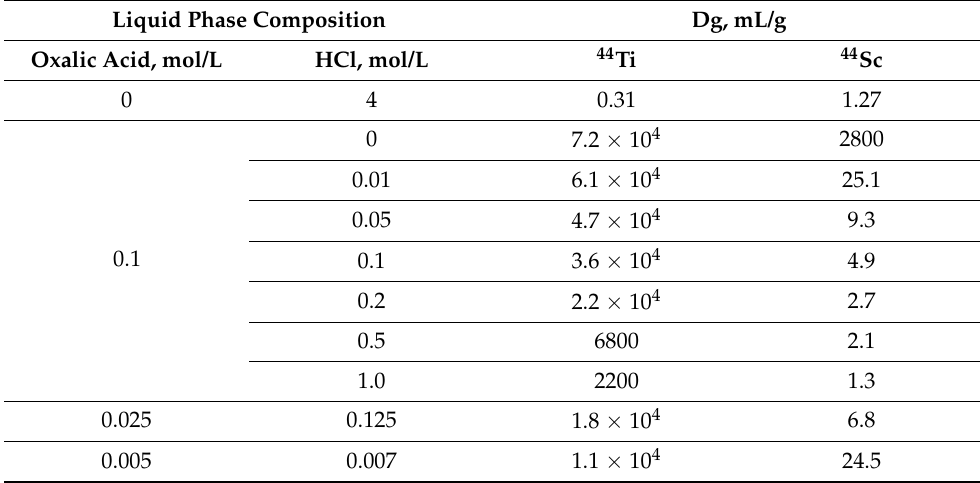
Table 1. Distribution coefficients (Dg) of 44 Ti and 44 Sc in various H 2 C 2 O 4 /HCl mixtures for TEVA